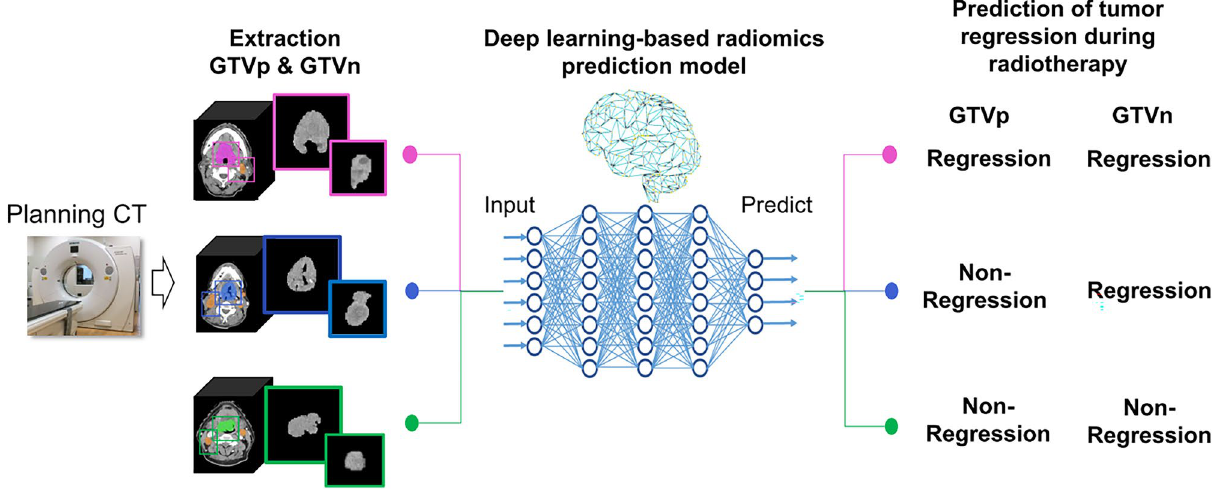
Figure 1. Schematic diagram of a deep learning-based radiomics approach for predicting early radiation- induced tumor regression utilizing only CT images of gross tumor volume (GTV) acquired before